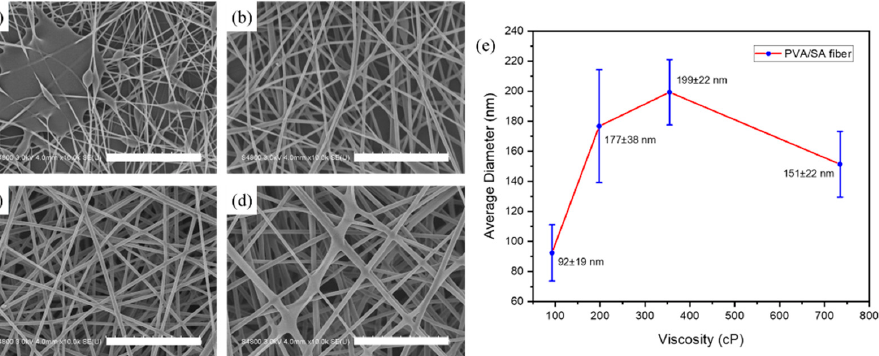
Figure 1. The SEM images of PVA/SA nanofiber were prepared by different precursors containing PVA (5, 6, 7, and 8 wt%) and 2 wt% SA with different viscosities: ( a ) 93 cP; ( b ) 198 cP; ( c ) 355 cP; ( d ) 734 cP. ( e ) the diameter of PVA/SA nanofiber followed by different viscosity. (The scale bar in the SEM image was 5 μ m).